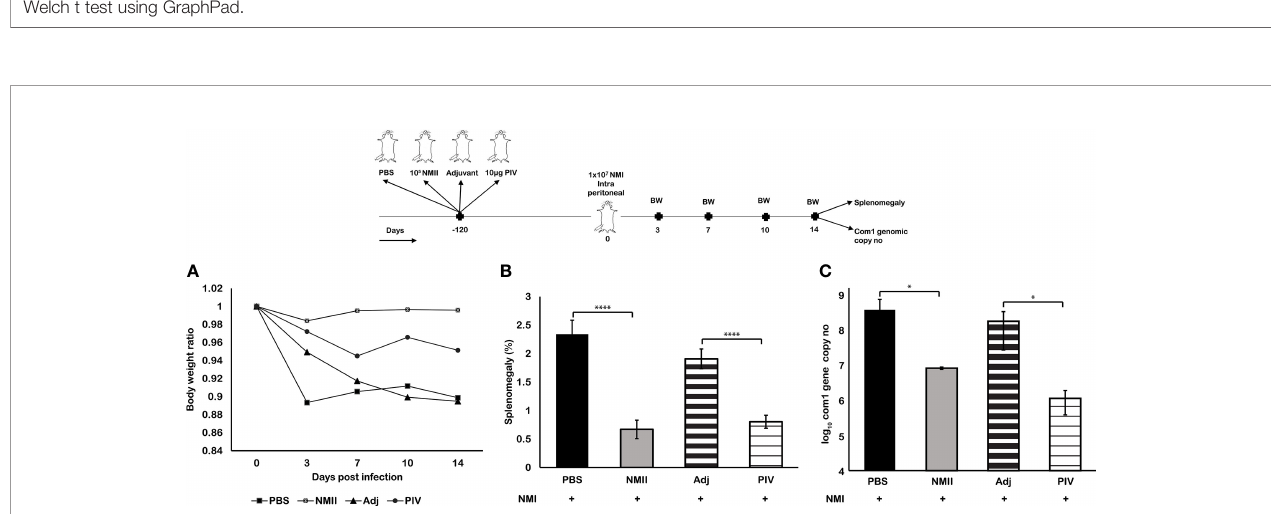
FIGURE 7 | Mouse immunization with viable NMII bacteria conferred long-term protection against virulent NMI challenge. BALB/c mice were SQ vaccinated with 10 5 GE of viable NMII; 10 µg of PIV, PBS, or adjuvant; and IP challenged with 10 7 GE NMI at 120 dpv. Body weight ratio (A) , splenomegaly ( B , % of spleen weight/body weight), and bacterial burden (log 10 C. burnetii com1 gene copy numbers) in the spleen (C) were evaluated at 14 dpi. Each experimental group includes four mice, with error bars representing the standard deviations from the means. *p < 0.05; ****p < 0.0001, as determined by Welch t test using